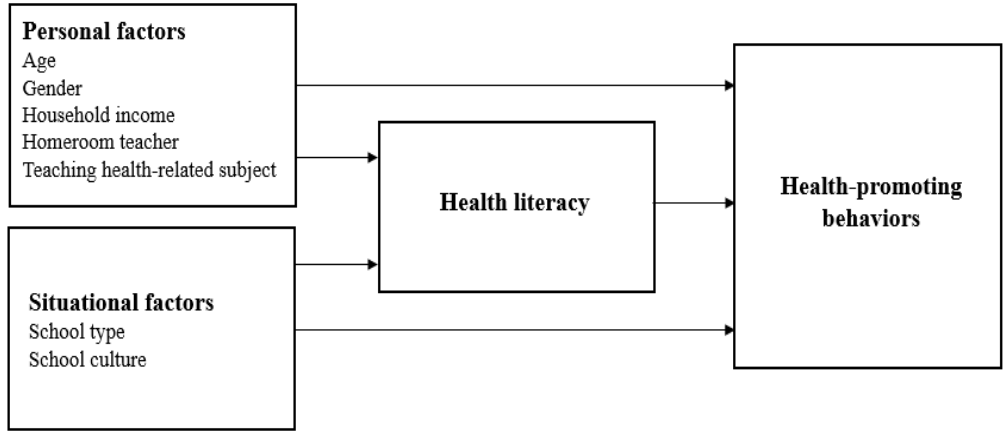
Figure 1. Conceptual framework of this study.